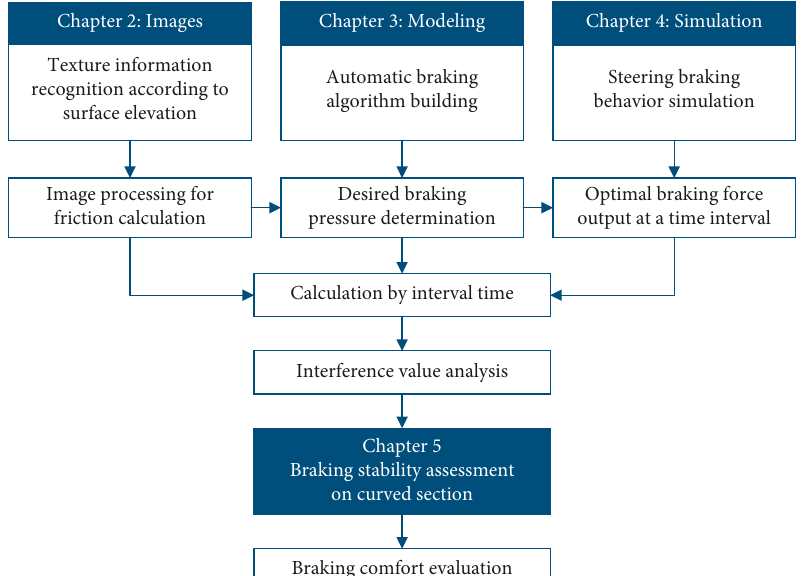
Figure 1: Research framework of this study.